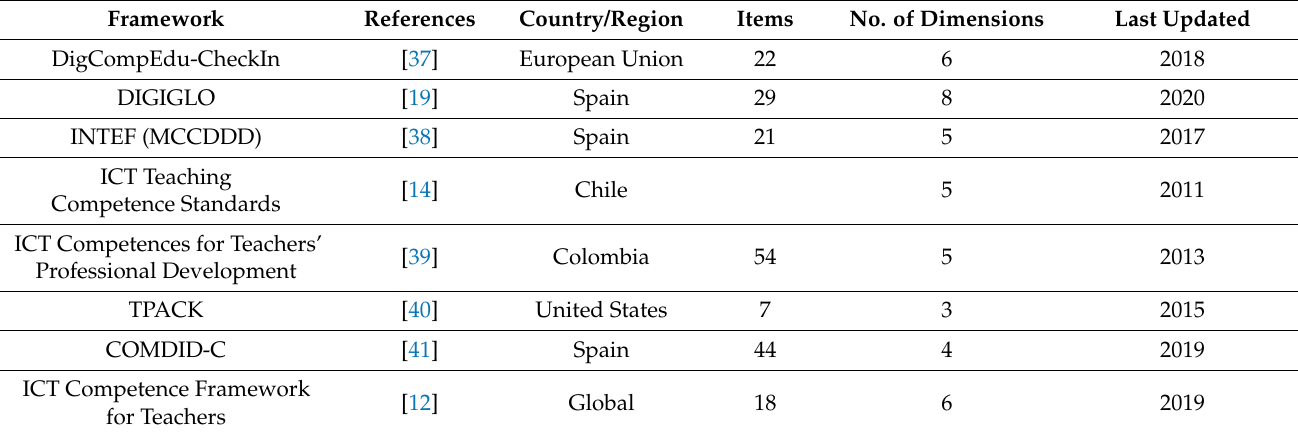
Table 6. General characteristics of digital competence frameworks.